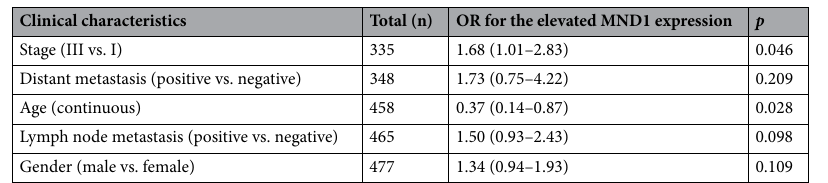
Table 2. Associations of MND1 expression with clinic-pathological features estimated by logistic regression analysis. Categorical dependent variable, greater or less than the median expression level.